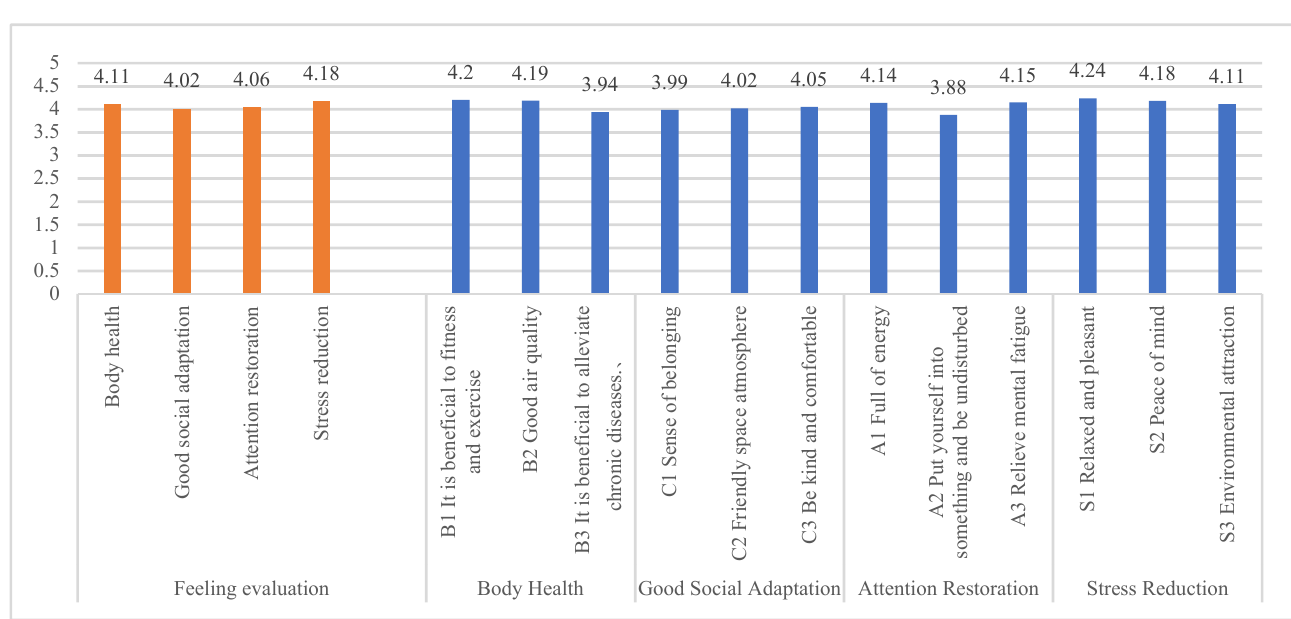
Figure 10. Results of user perception evaluation in community parks.